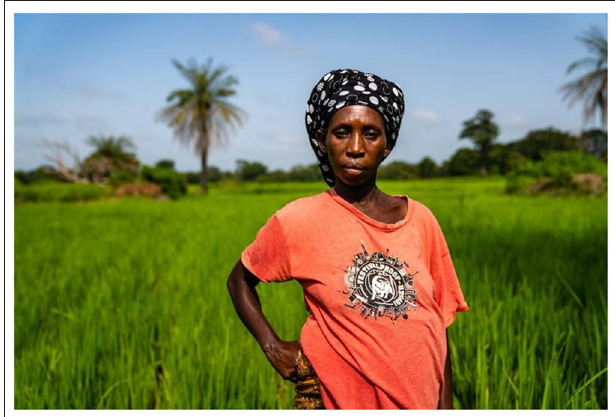
FIGURE 1 | Binta is a woman residing in Keneba village, working in her rice fields while